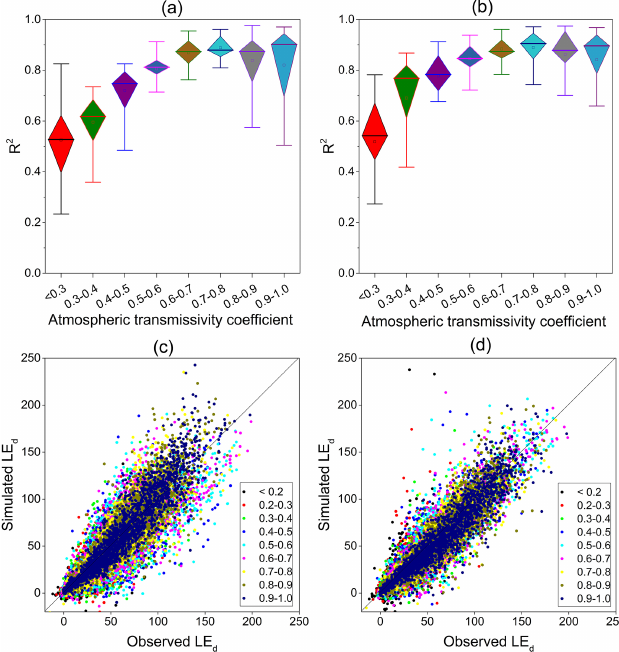
Figure 8. Box plots showing the R 2 of the (a) sine function method simulated by a single time at 10:30 and the (b) EF(PET) method simulated by multi-time values at 13:30 for each site. Scatter plots between observed and simulated daily LE by the (c) sine function and (d) EF(PET) methods under differing daily atmospheric trans- missivity